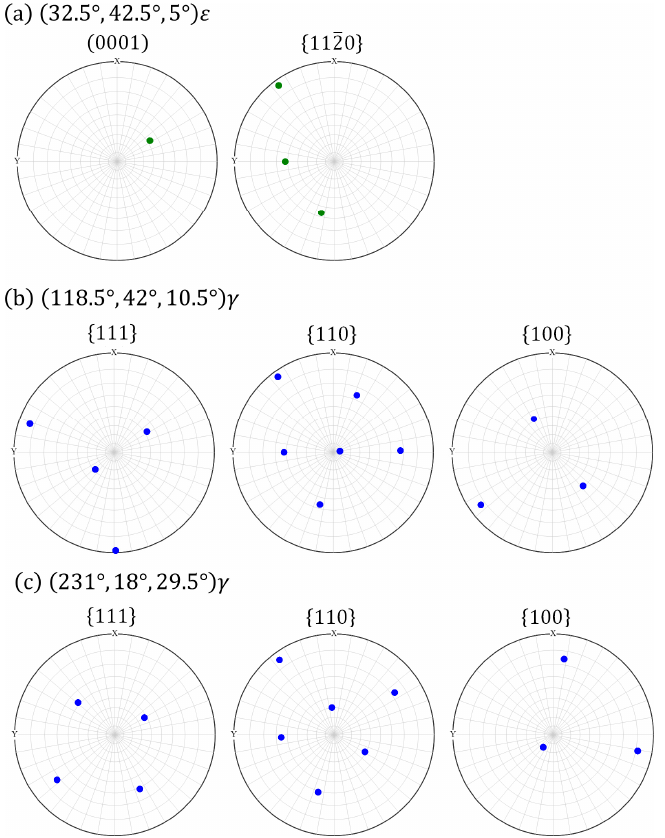
Figure 8. Pole plots of the ( a ) M texture component of the ε phase and ( b , c ) the candidate orienta- tions of the γ phase, which can transform into the M-oriented ε phase. of the γ phase, which can transform into the M-oriented ε